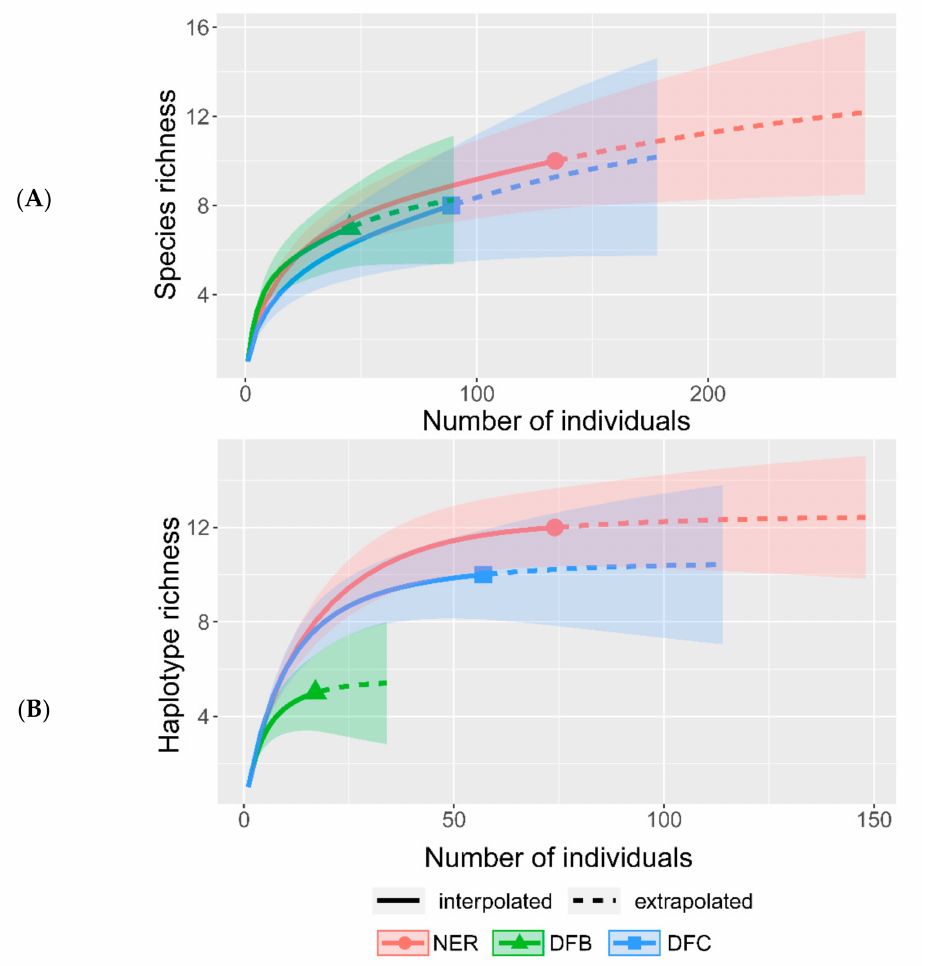
Figure 3. Rarefaction curves for total species richness ( Beauveria spp. and other arthropod-pathogenic species isolated in this study; ( A ) and for B. pseudobassiana haplotype richness ( B ) observed in northern European Russia (NER) and the southern (dfb) and northern (dfc) climate zones. Rarefaction curves for B. bassiana and B. caledonica could not be obtained due to insufficient data. Shaded areas on plots correspond to 95% confidence